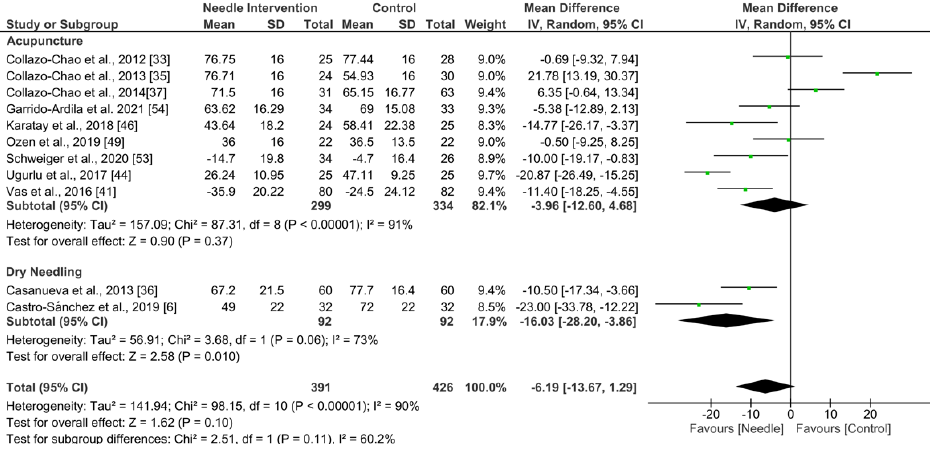
Figure 5. Forest plot for FIQ after 0 – 3 months.